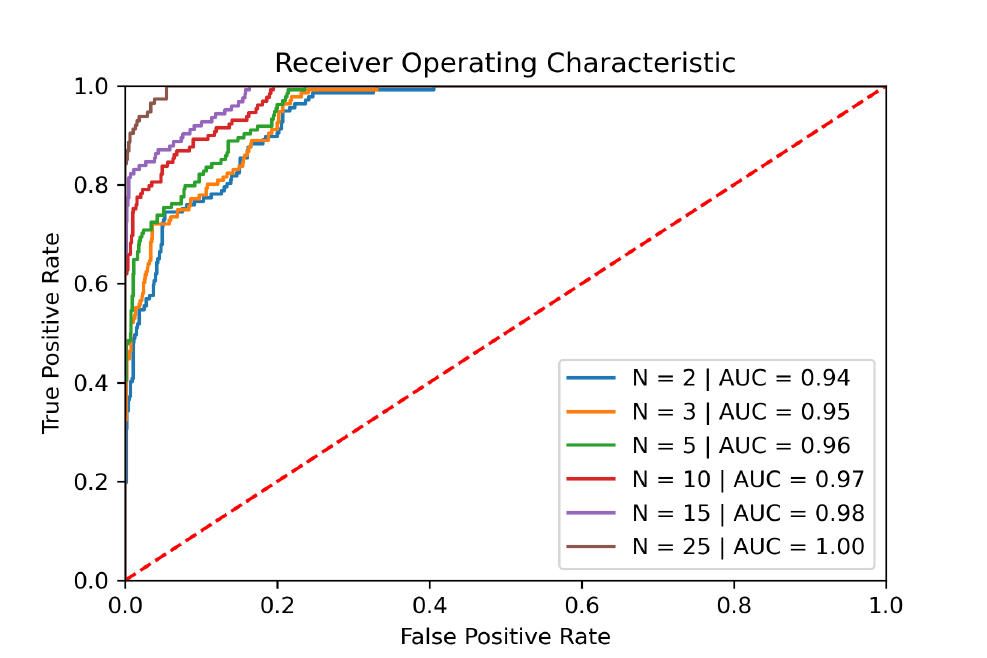
Figure 8. ROC multiple gestures for position, accelerometer and timestamp data with gesture lengths bigger than 50—4 hidden states and 4